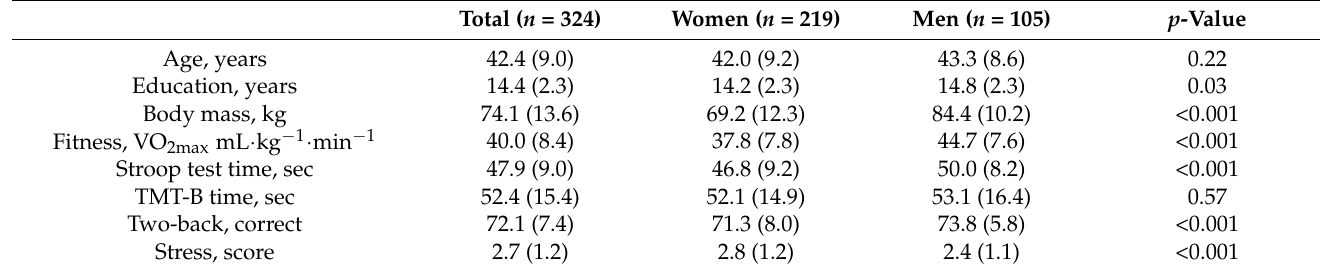
Table 1. Means and standard deviations of study participants’ characteristics.